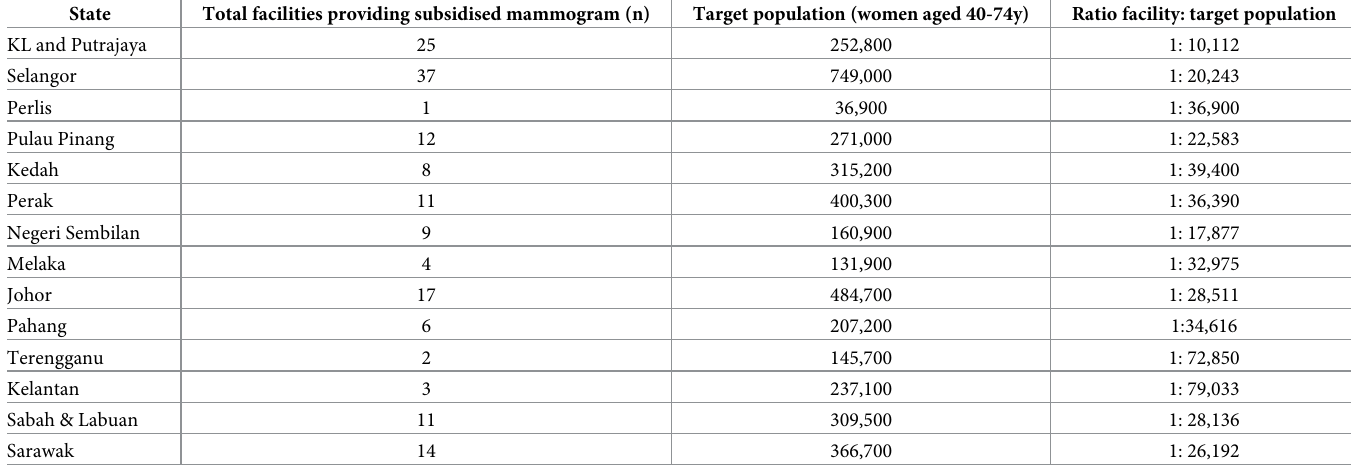
Table 1. Ratio of facilities involved in providing mammogram to target population according to state.